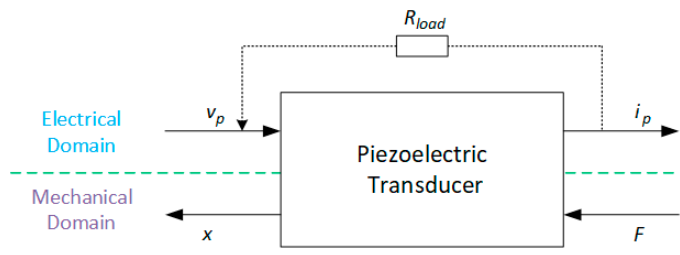
Figure 11. Two-port network model for the piezoelectric transducer.